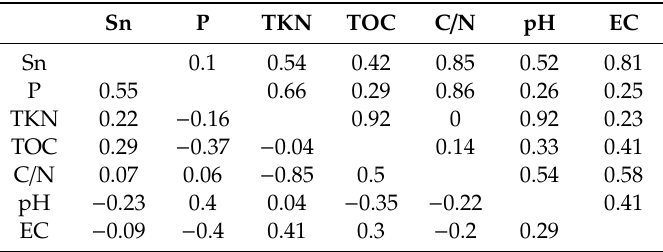
Table 5. Nr soil parameters’ correlation coefficients (left down) and corresponding p -values (right up); significant cases are highlighted.